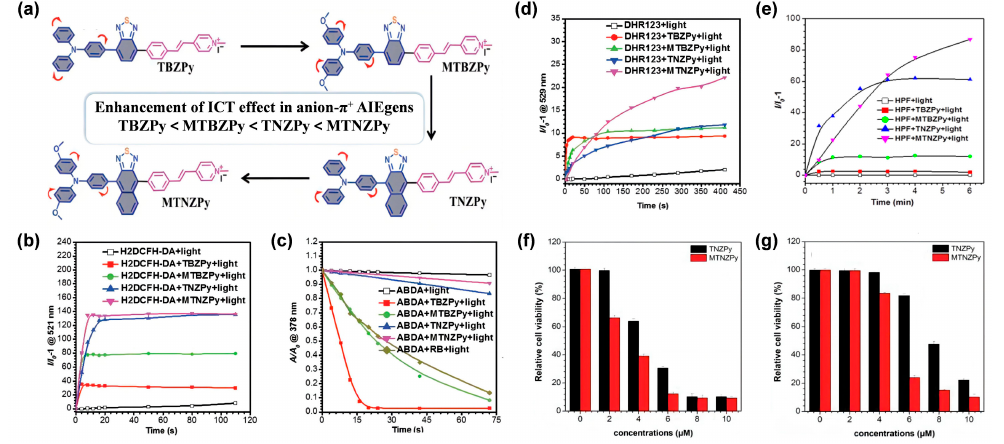
Figure 3. ( a ) Chemical structures and the order of ICT effect of TBZPy, MTBZPy, TNZPy,